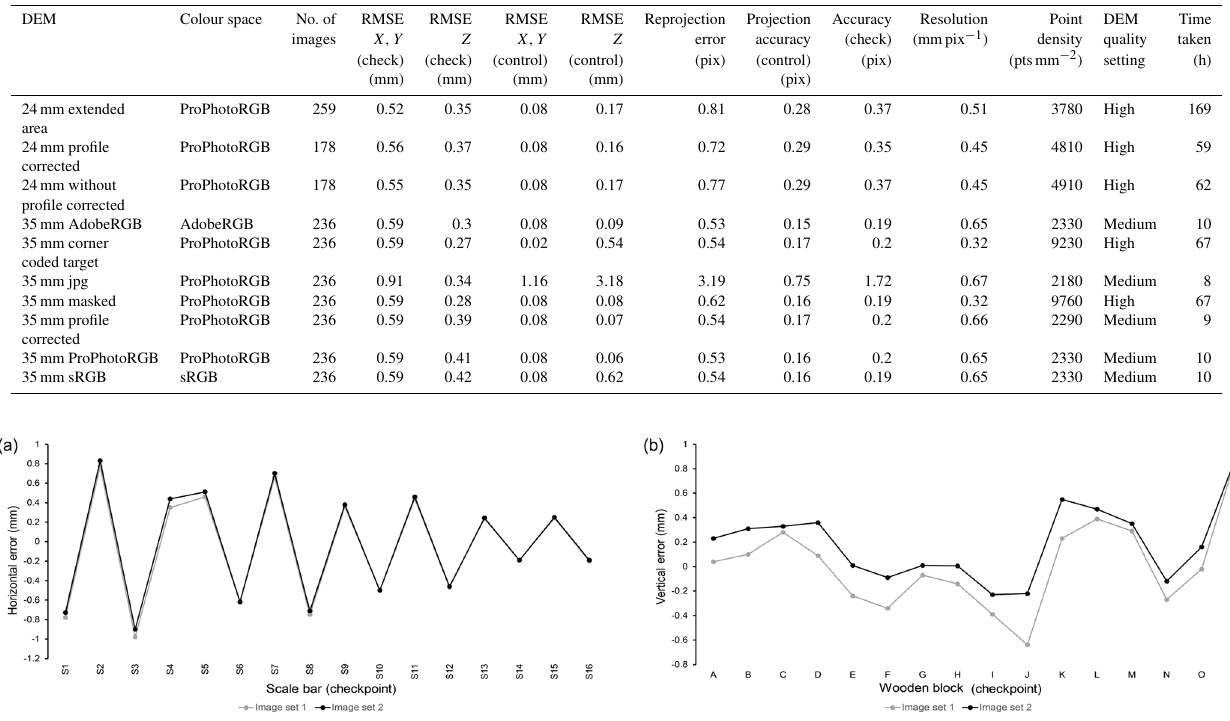
Figure 6. (a, b) Horizontal checkpoint and vertical checkpoint errors in DEMs produced from two different image sets to test